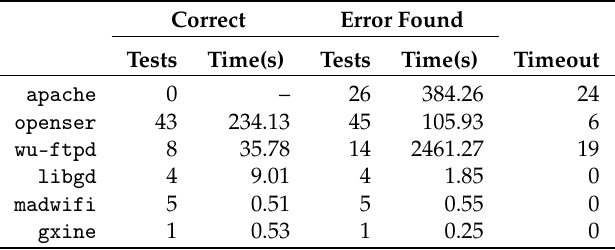
Table 5. Veriabs overflow benchmarks depict a few categories of programs exhibiting an overflow error and their fixed variants. The table shows the number of solved benchmarks ( tests ) and accumulated time for each category. For each category, the table depicts correctly verified benchmarks, benchmarks where the verifier was able to find an error and number of timeouts. Correct Error Found Tests Time(s) Tests Time(s)